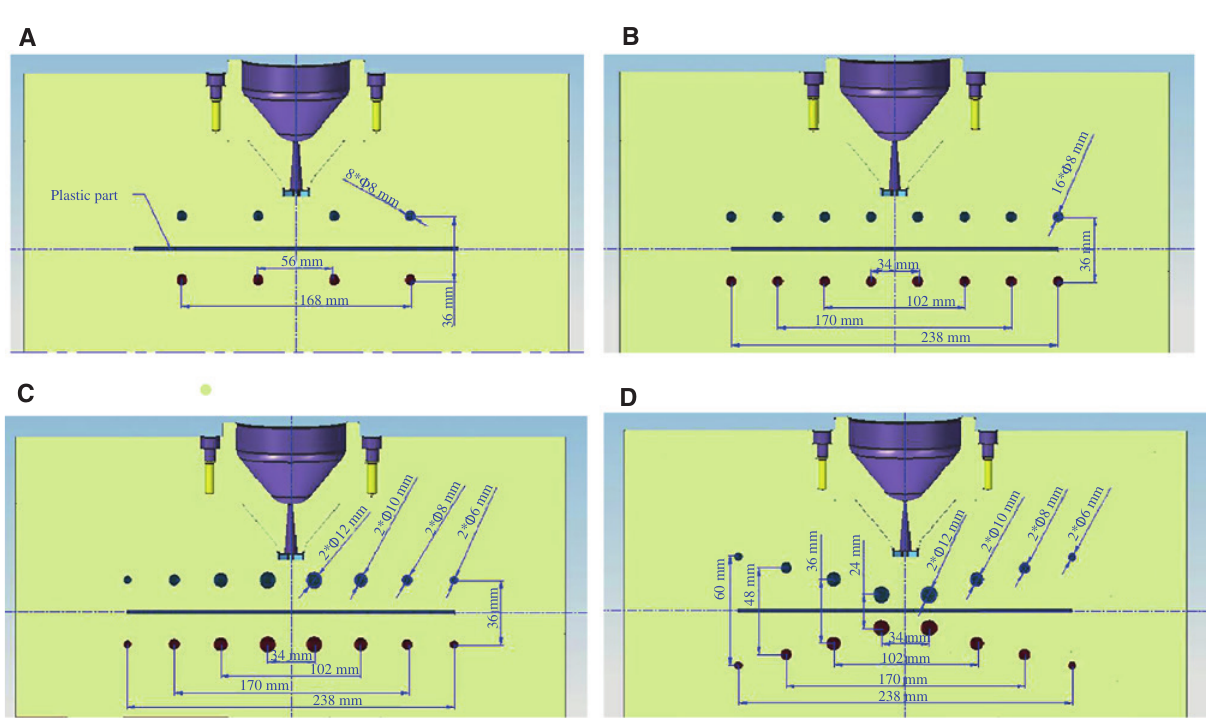
Figure 5: The cooling plans: (A) cooling plan 1, (B) cooling plan 2, (C) cooling plan 3, and (D) cooling plan 4.